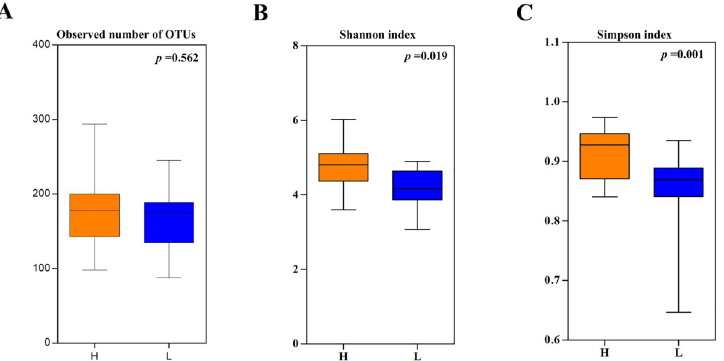
Fig 1. The α -diversity indexes of the faecal microbiota in the samples of the higher-level athletes (H) and lower- level athletes (L). (A) Observed operational taxonomic units (OTUs) (180.8 ± 58.31 vs. 164.4 ± 41.93, p = 0.562) between the H group and the L group. (B) Shannon diversity index (4.797 ± 0.722 vs. 4.148 ± 0.543, p = 0.019) between the H group and the L group. (C) Simpson diversity index (0.915 ± 0.044 vs. 0.856 ± 0.066, p = 0.001) between the H group and the L